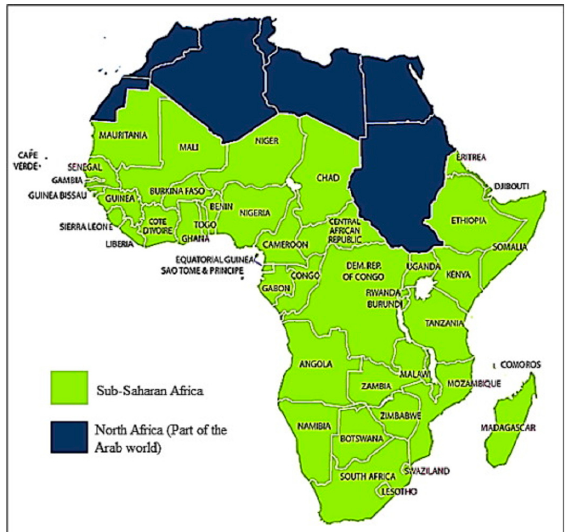
Figure 4. Map of Africa, demarcating Saharan and sub-Saharan Africa [79] .